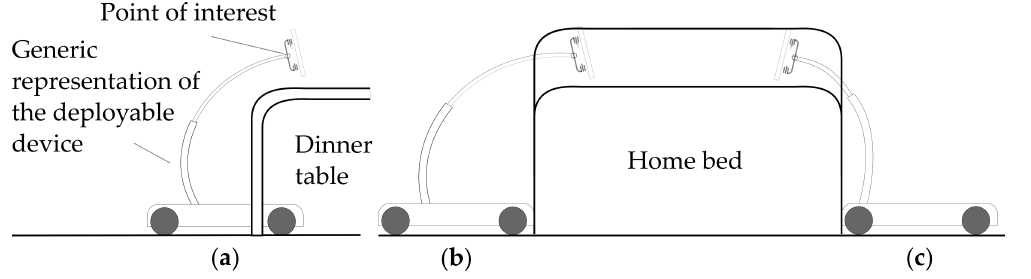
Figure 2. Schematic representation of the system in three situations: ( a ) table approach with under- motion allowed, ( b ) bed approach with the positioning device mounted on the opposite side relative to the deployment direction, ( c ) bed approach with the positioning device mounted on the approach